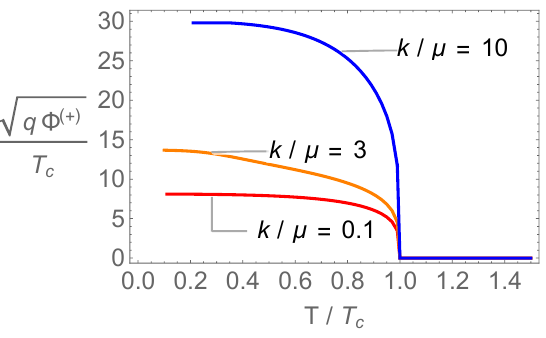
√ 3 where T c is the critical temperature.